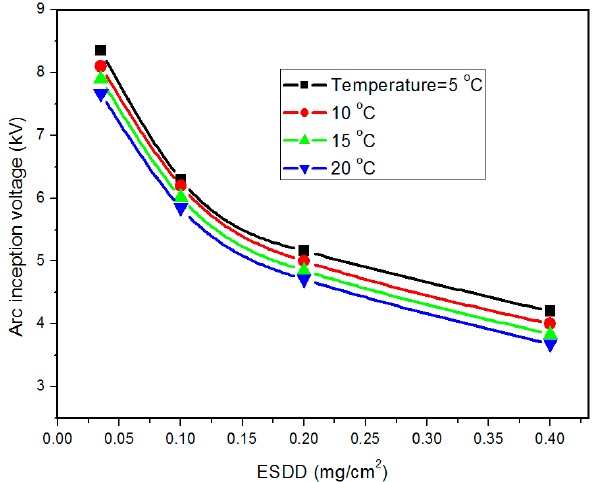
Figure 8. Arc inception voltage at different temperature, where pollution distribution = uniform, NSDD = 0.75 mg/cm 2 , humidity level = low, and standard deviation = 3.1%–4.7%.